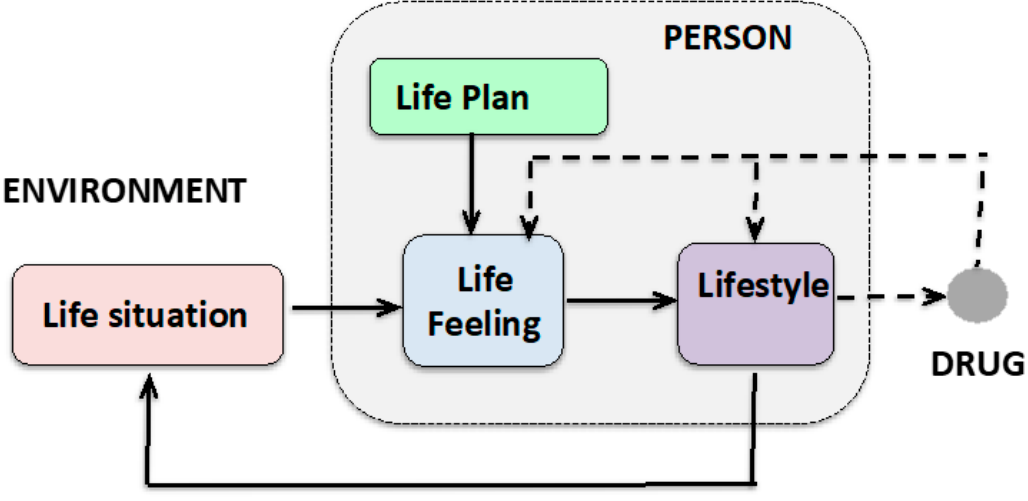
Figure 4. Lifestyle as a system of human – environment relations on a micro-level referred to a daily lifecycle and embedded in macro-level life conditions: From morning hygiene to dressing, nutrition,